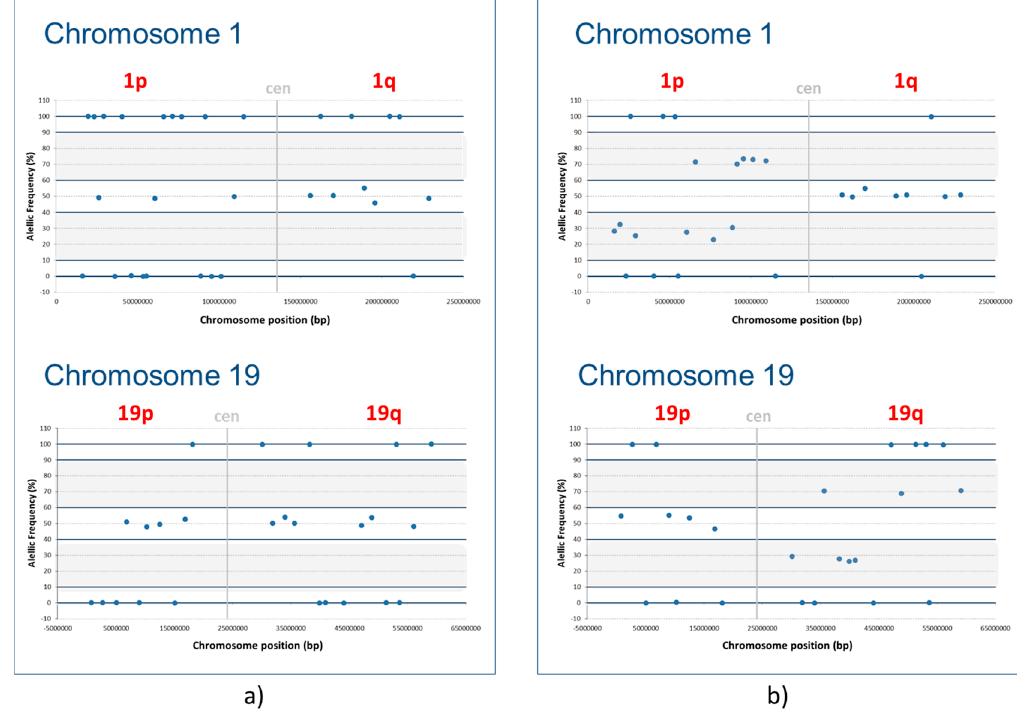
Figure 1. Analysis of the 1p/19q codeletion through the detection of single-nucleotide polymorphism (SNP)-based loss of heterozygosity (LOH), using the designed next-generation sequencing panel. ( a ) Representative 1p/19q non-codeleted sample. ( b ) Representative 1p/19q codeleted sample. For each sample and chromosome, the allelic frequency is represented according to the SNP location. The established ranges for homozygosity were defined between 0% and 5% (same allele as that of the reference genome) and between 90% and 100% (different allele than that of the reference genome). The range of heterozygosity was defined as being between 40% and 60% of allelic frequency (AF). The LOH for an SNP was defined as when the AF was outside of the established ranges for homozygosity or heterozygosity (gray areas). A sample was scored as having 1p/19q LOH when all 1p and 19q markers had LOH or were homozygous, and at least one marker in the opposite arm (1q and 19p) were heterozygous.